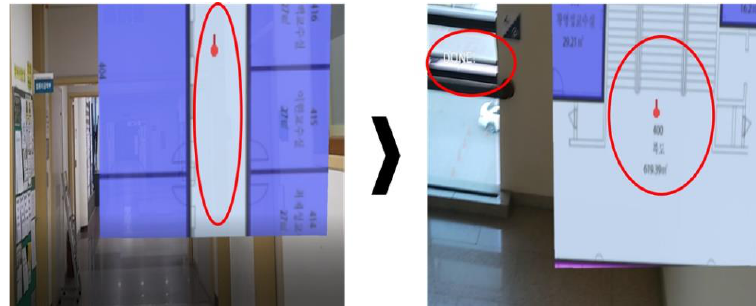
Figure 14. Escape process after victim rescue.